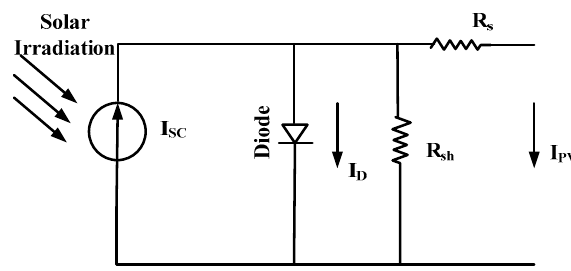
Figure 3. Equivalent circuit of a PV array.